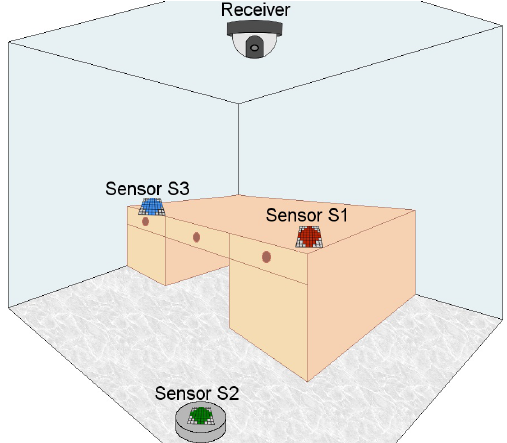
Figure 1. Wireless Sensor Network implementation using Optical Camera Communication (OCC) in an office (3 × 3 × 3 m 3 ). The receiver is a dome camera installed in the ceiling (height 3.00 m) with 90 ◦ Field of View (FOV). The sensor’s emitters are LED matrices (60 × 60 mm 2 ). Two sensors are located on the desk (height 0.80 m) and one sensor is over an autonomous robotic vacuum cleaner (height 0.10